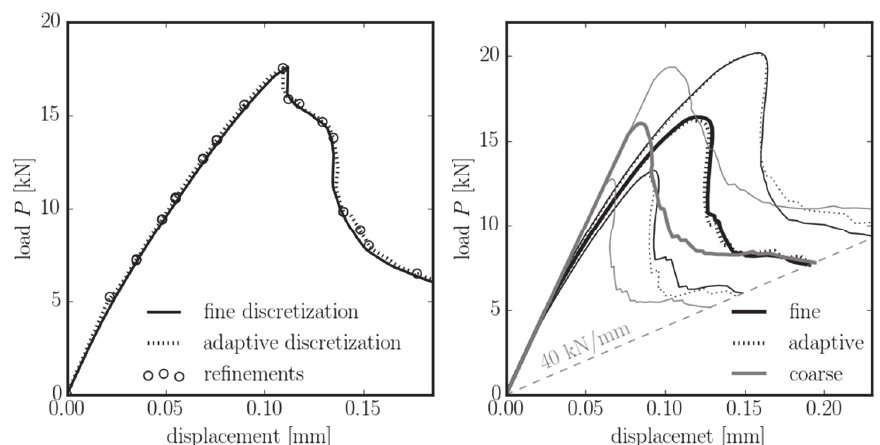
Figure 3: Left: Load-displacement response of one four-point-bending test simulation using the fine model and the adaptive model with the same refined meso-structure. Right: Average response of 30 simulation of four-point-bending